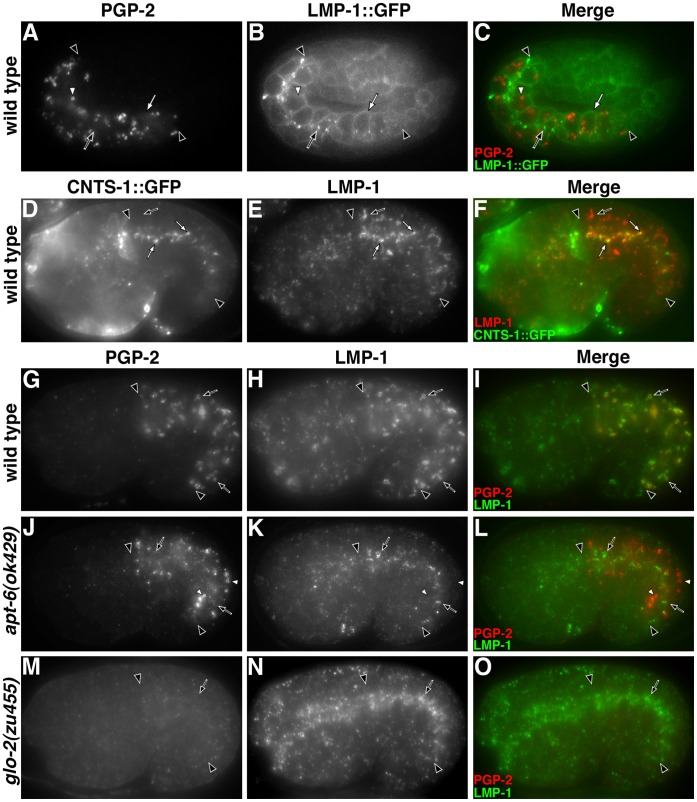
Analysis of LMP-1 trafficking.(A–C) In intestinal cells LMP-1::GFP localized to the basolateral plasma membrane (white arrow) and apically enriched organelles (black arrow) that did not overlap with PGP-2 containing gut granules (white arrowhead). (D–F) Endogenous LMP-1 localized to apical CNTS-1::GFP containing conventional lysosomes (white arrows) and more basally localized compartments (black arrow) lacking CNTS-1::GFP. (G–I) In the basal region of the intestine, LMP-1 localized to PGP-2 containing gut granules (black arrows). (J–L) In a mutant lacking AP-3 function, gut granules containing PGP-2 (white arrowhead) lacked LMP-1, which was restricted to apical compartments (black arrows). (M–O) PGP-2 containing organelles were lacking in glo-2(zu455) embryos and LMP-1 was enriched on apically localized organelles (black arrows). In all panels, black arrowheads flank the intestine. In A–C a pretzel stage embryo and in D–O 1.5-fold stage embryos are shown.